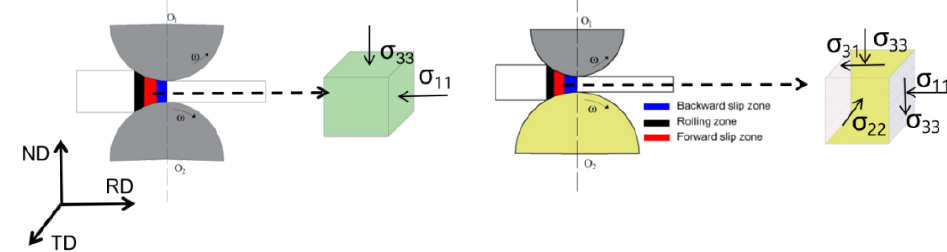
Figure 1. Schematic diagram of the stress state in the rolling experiment.